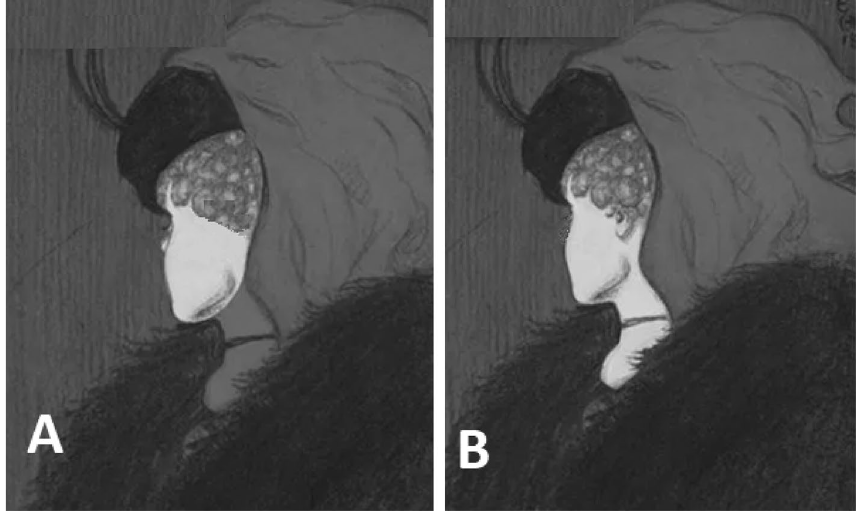
Figure 2. Figure highlighting the young woman ( A ) and the older lady ( B ) after Shakhnazarova